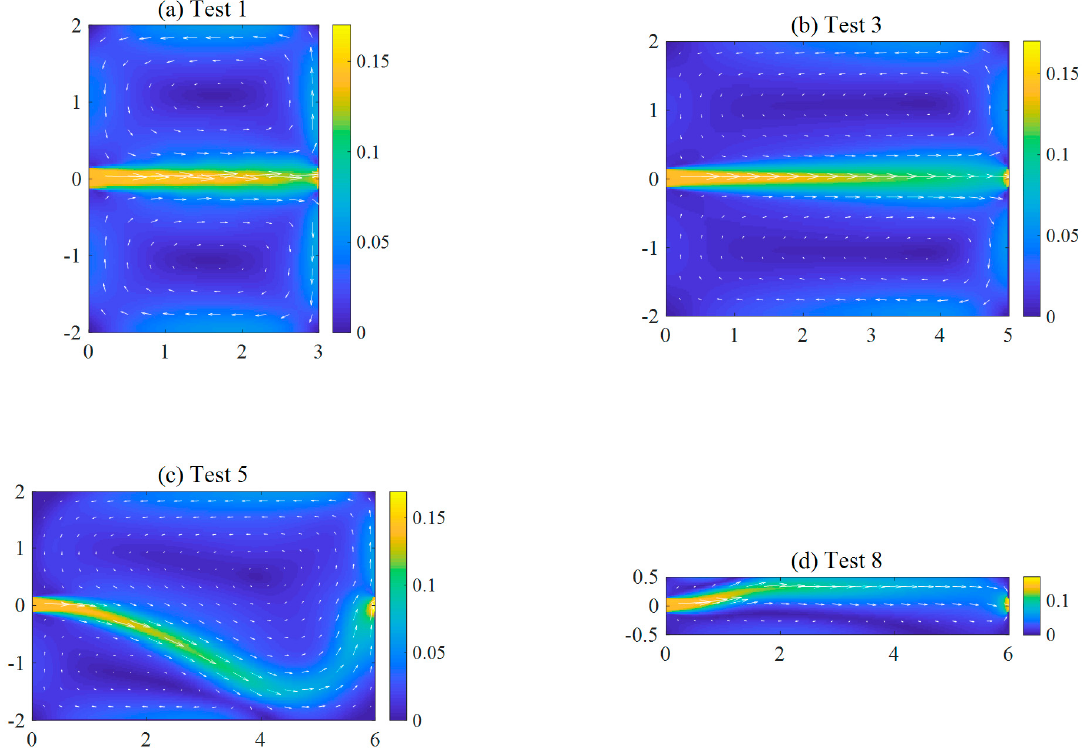
Figure 2. Examples of computed flow fields: ( a ) detached jet, ( b ) detached jet, near transition, ( c ) reattached jet, and ( d ) reattached jet with plug flow in the downstream part of the reservoir [18]. The color scale represents the velocity magnitude (m/s).